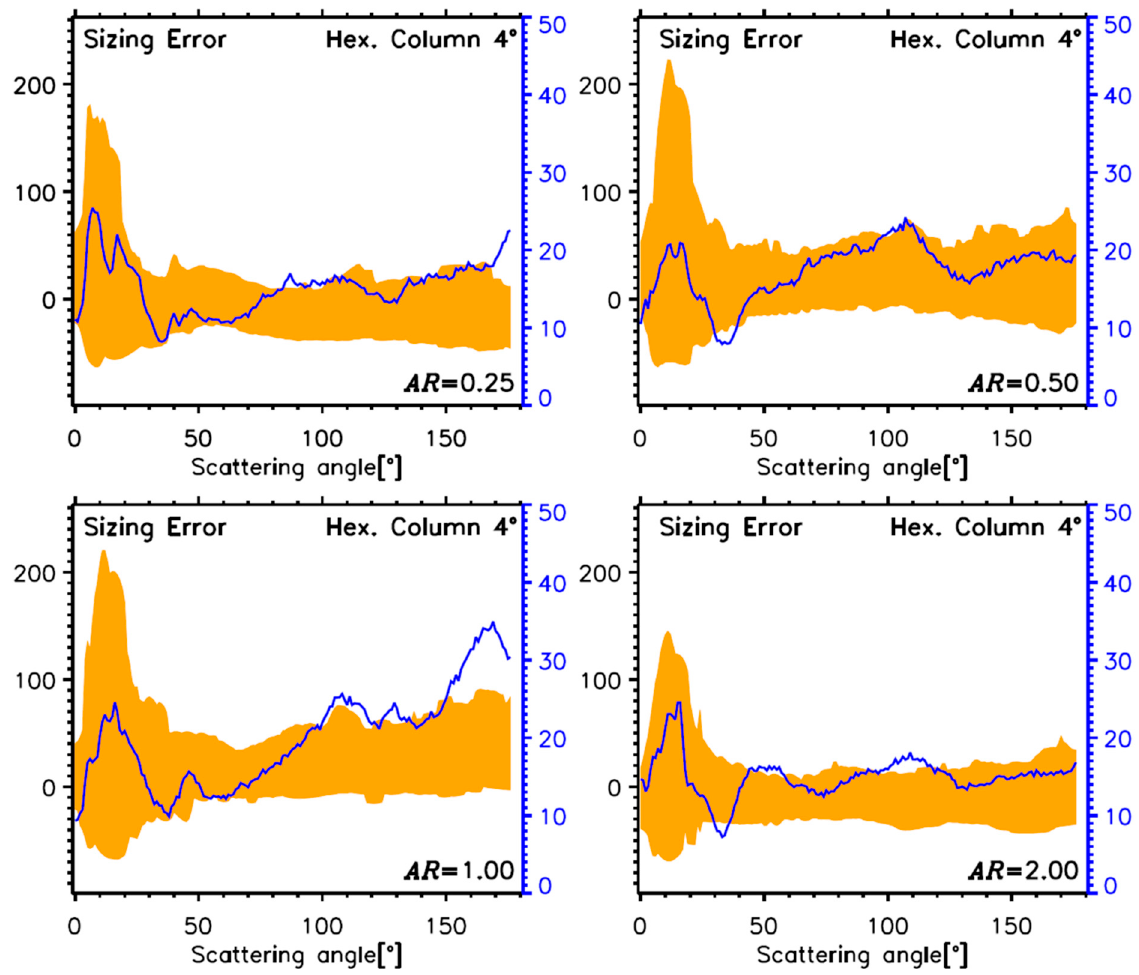
Figure 15. Determined ranges (orange shaded areas, left vertical axis) of minima and maxima and average (blue lines, right vertical axis) of sizing errors (%) for measured hexagonal ice crystals with AR = 0.25, 0.50, 1.00, and 2.00 using the ADDA as a function of scattering angle. The 4° resolution of scattering angles are shown.